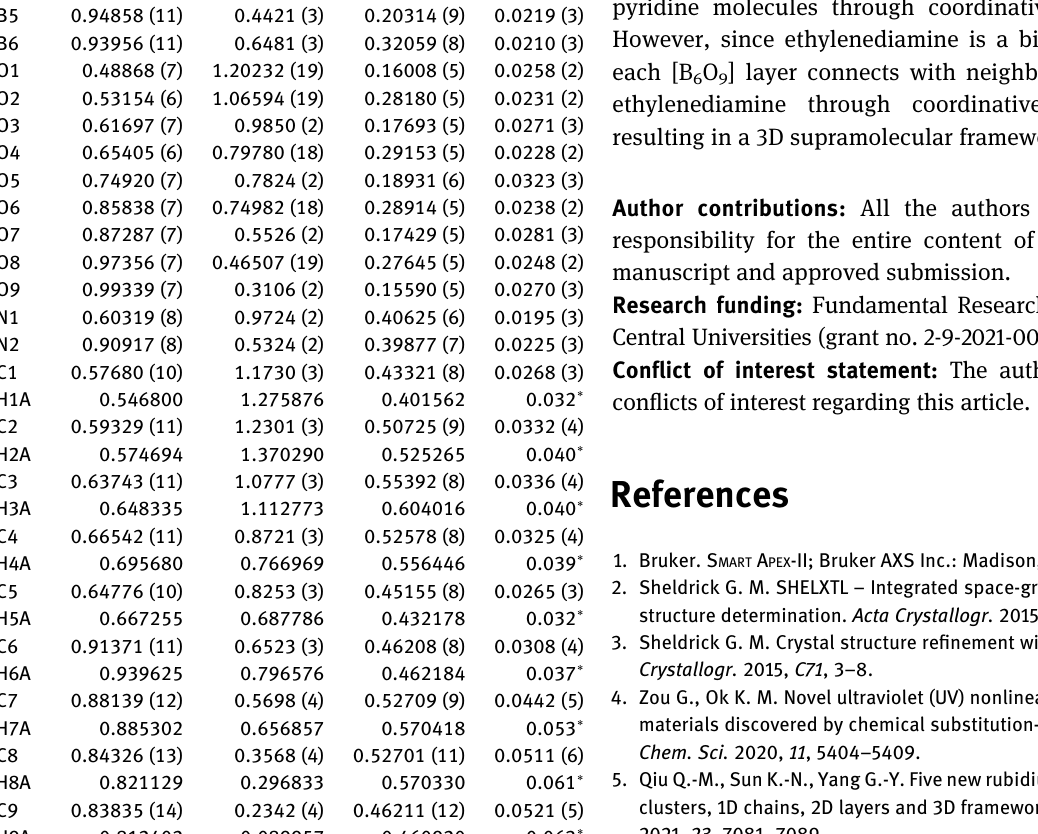
frameworks containing coordinative B – N bonds are un- usual [7, 8]. The asymmetric unit of the title compound consists of two six-membered rings each comprising one triangular BO and two tetrahedral BO N groups. The average B – O 3 3 distances around three- and four-coordinate boron atoms are 1.368(2) and 1.442(2) Å, respectively. The B – N distance